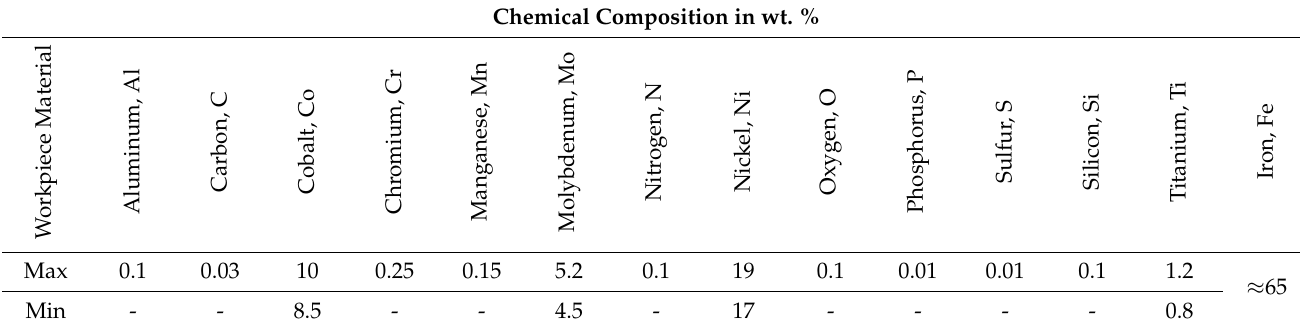
Figure 2. Schematic representation of the laser scanning strategy. Table 1 shows the chemical composition of steel 1.2709. Table 1. Chemical composition of maraging steel 1.2709 (powder). Chemical Composition in wt. %